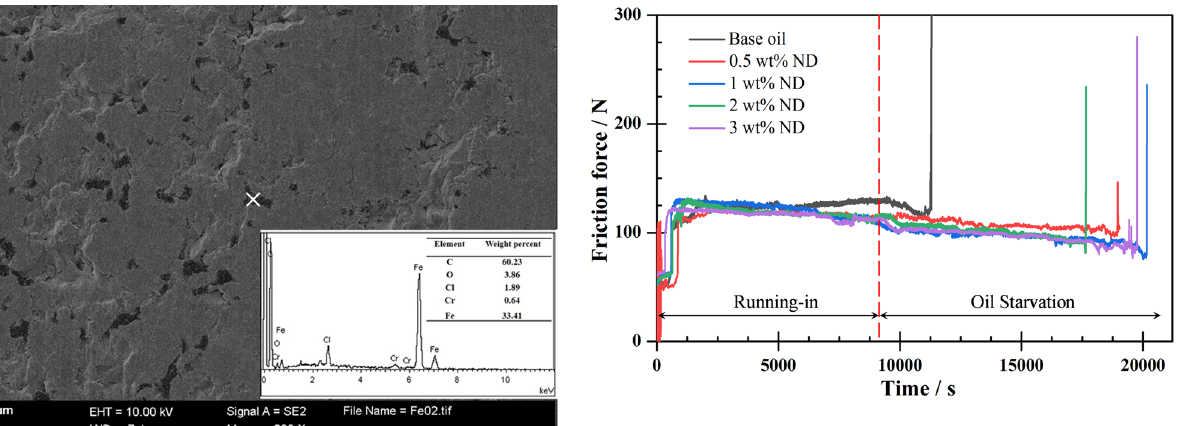
Figure 12: The typical friction force variation of the Cr liner and the CrN - coated piston ring under 20 MPa in scu ffi ng resistance